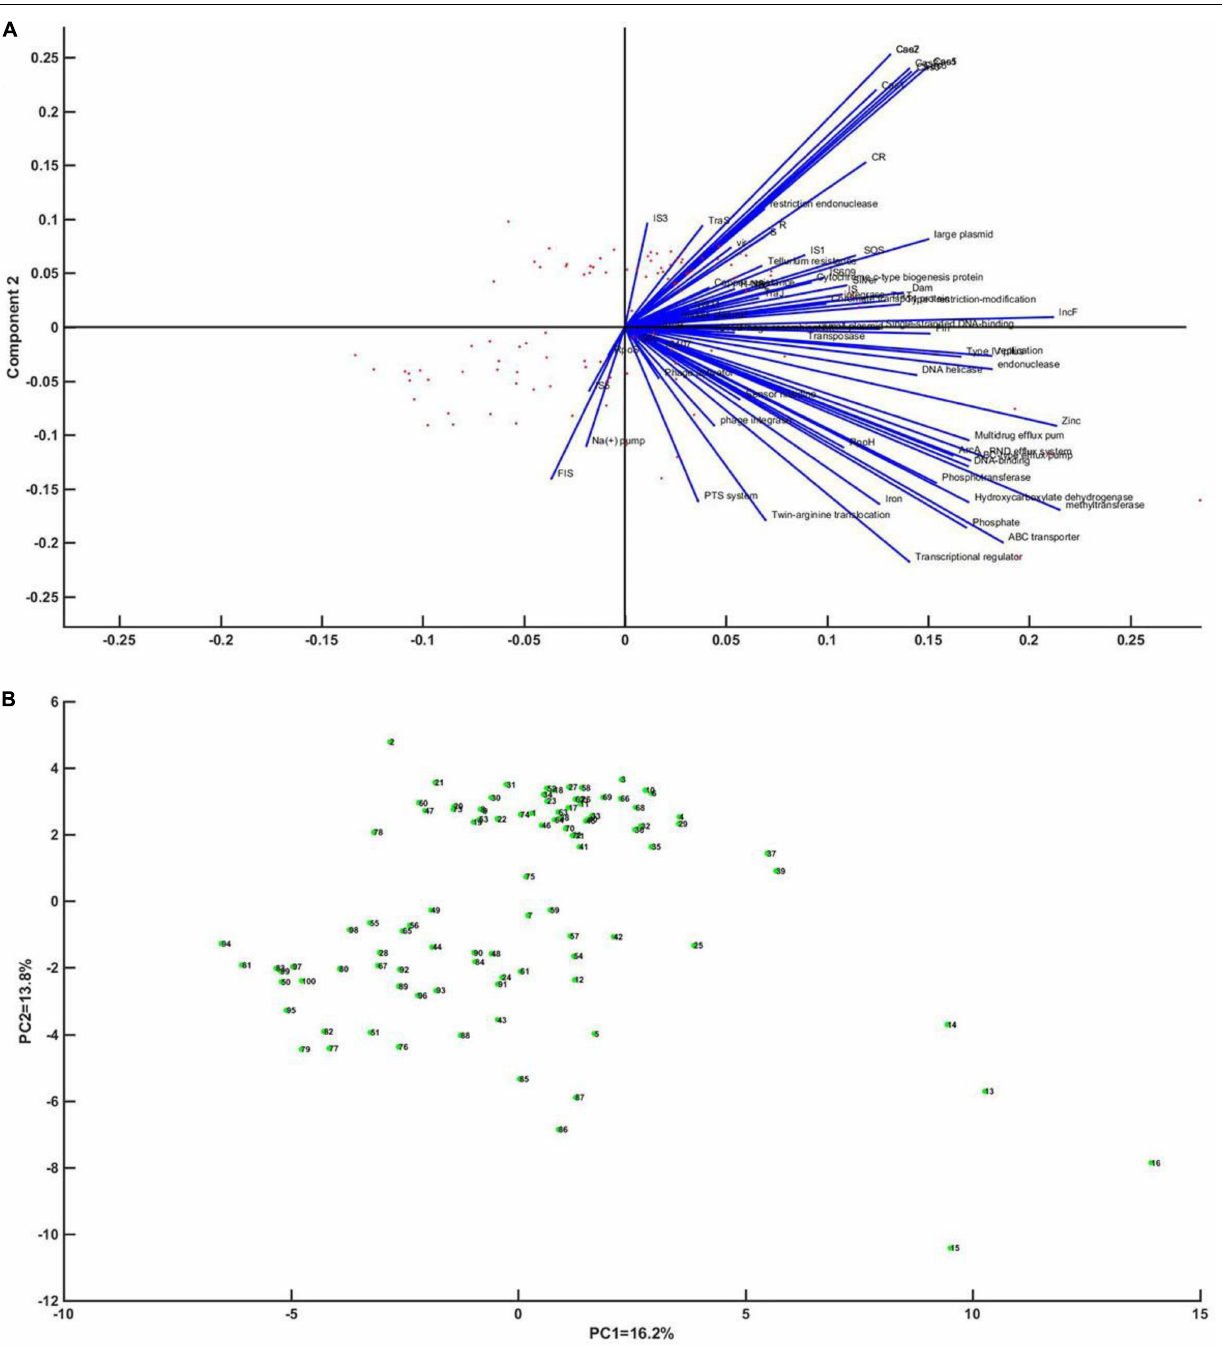
FIGURE 4 | Principal component analysis of CRISPR of Klebsiella in relation to mobile genetic elements, regulators and enzymes of DNA metabolism. (A) Correlation vector diagram of each factor of principal component axis (blue line) and Klebsiella strains (red dot). A vector represents the correlation of each factor with the axis of the first principal component. (B) An enlarged view of the point representing Klebsiella